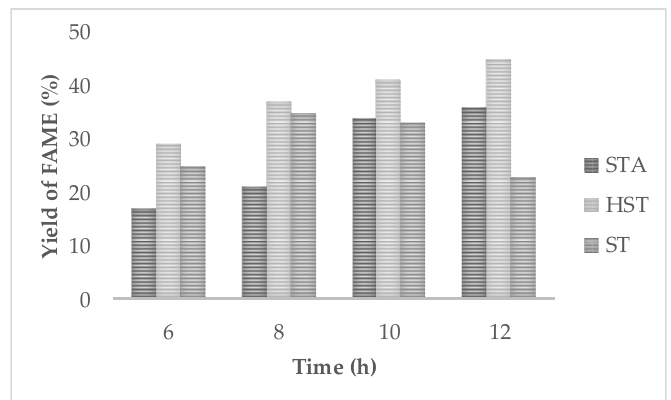
Figure 4. Influence of reaction time on the yield of FAME.